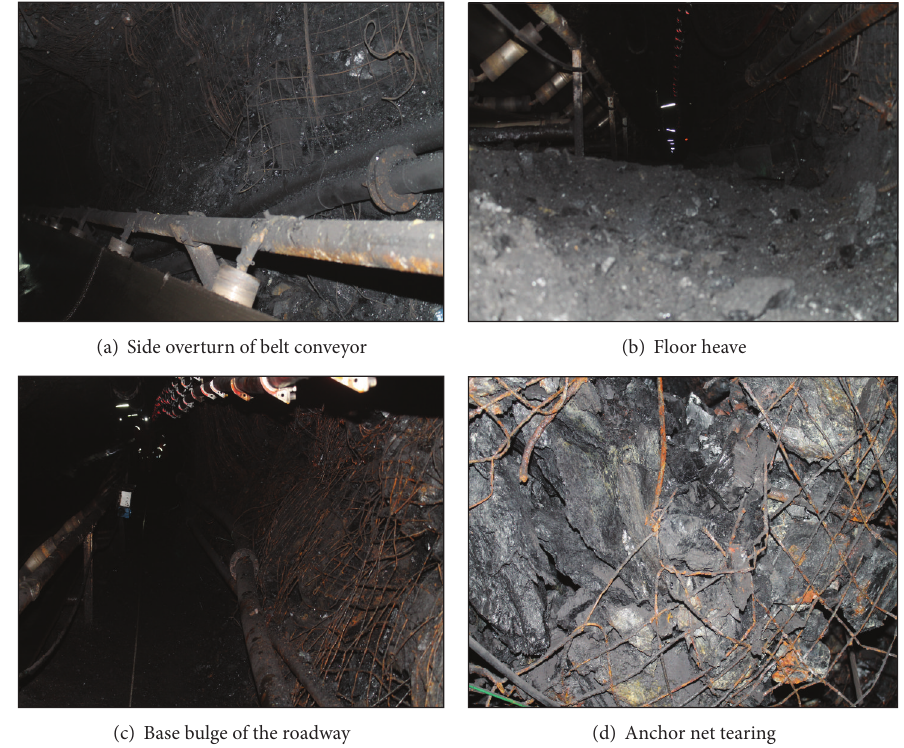
Figure 8: Description of destroying phenomena of the 9.18.